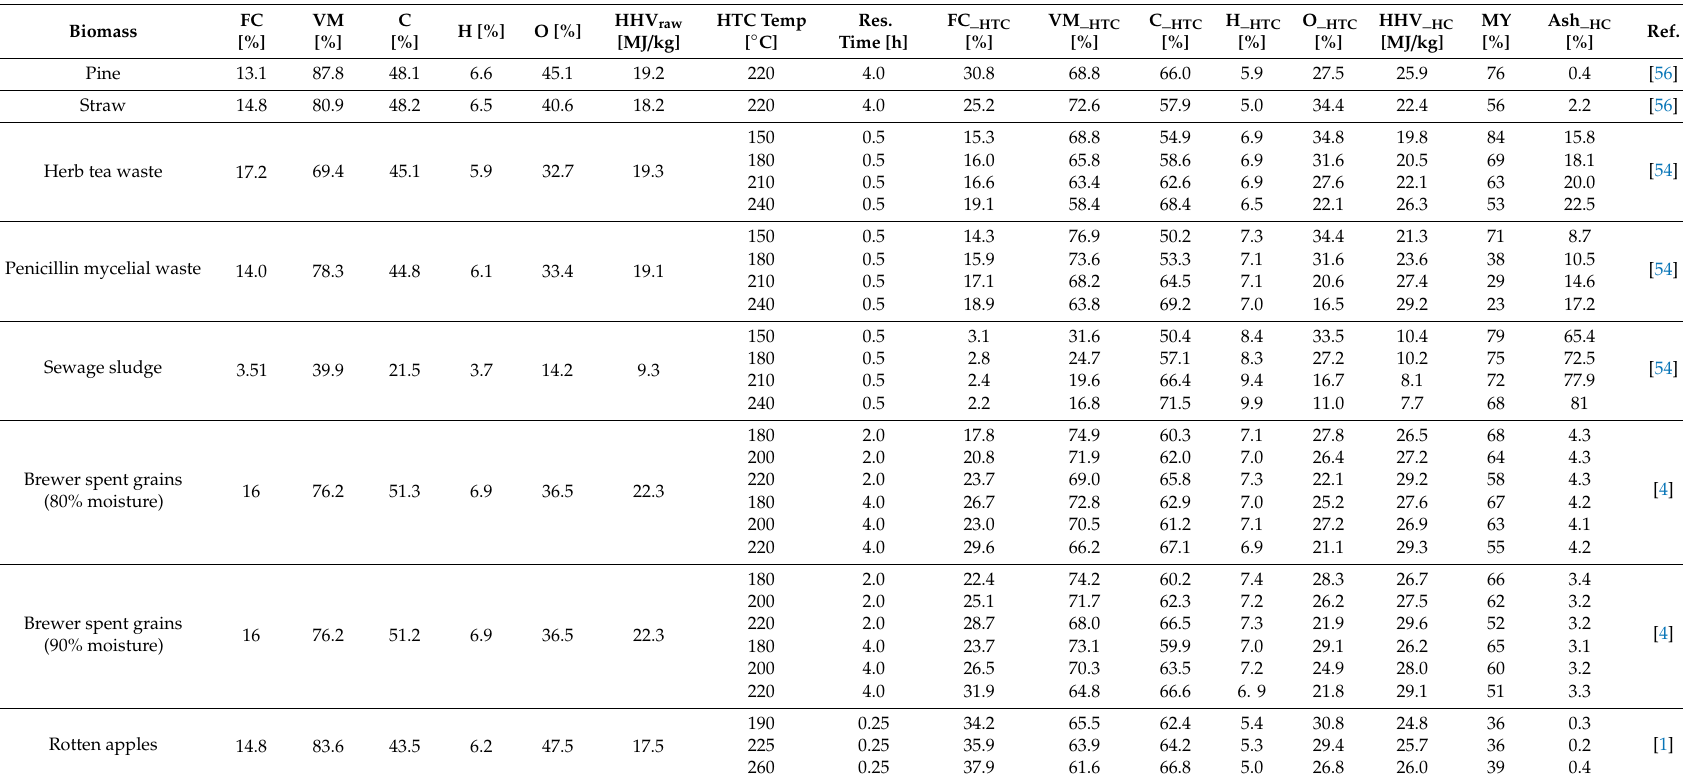
Table 1. E ff ect of HTC reaction parameters on hydrochar composition, calorific value and mass yield, together with coal properties as